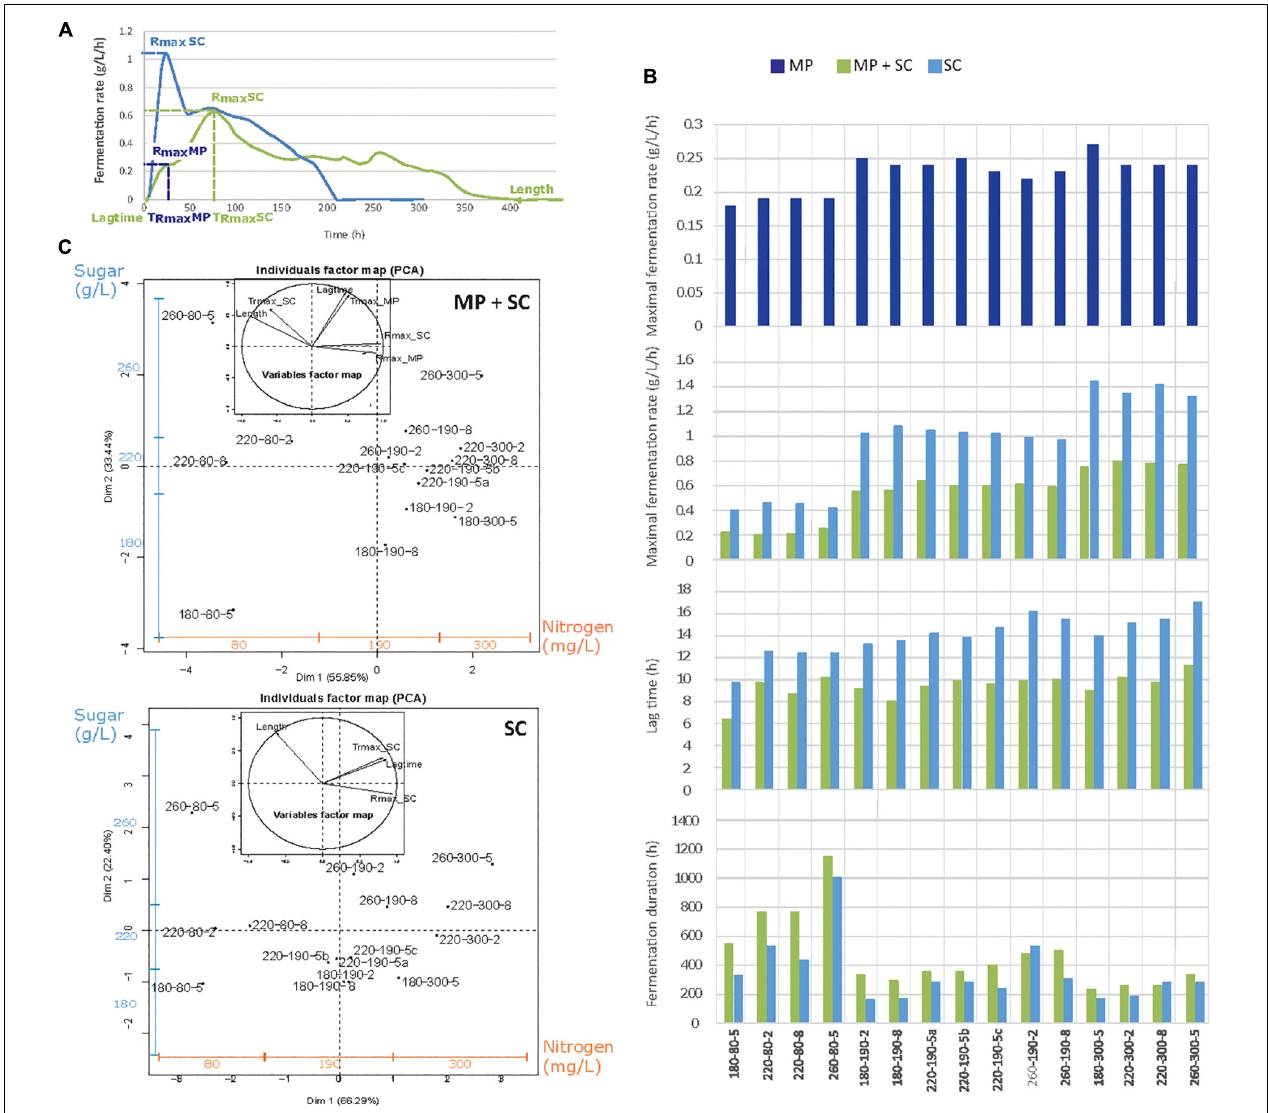
FIGURE 1 | (A) Example of the fermentation kinetics of M. pulcherrima and S. cerevisiae under sequential inoculation (MP + SC, green line) and S. cerevisiae in pure culture (SC, blue line). (B) Parameters describing the fermentation kinetics depending on the medium composition and inoculation strategy: Rmax_MP, maximal fermentation rate for M. pulcherrima reached before the inoculation of S. cerevisiae ; Rmax_SC, maximal fermentation rate for S. cerevisiae ; lag phase duration and fermentation duration. MP, dark blue bars: pure culture of M. pulcherrima . MP + SC, green bars: sequential fermentation. SC, blue bars: pure culture of S. cerevisiae . Conditions are labeled as sugar-nitrogen-lipids. (C) Principal component analysis (PCA) of fermentative parameters under the sequential inoculation of M. pulcherrima and S. cerevisiae and in pure cultures of S. cerevisiae . Individuals are identified as S-N-L, where S, sugar concentration; N, nitrogen concentration; and L, lipid concentration. The blue and orange additional axes indicate the repartition of individuals according to the concentrations of sugar (180–220–260 g/L) and nitrogen (80–190–300 mg/L). The inserts correspond to the correlation circles representing the explanatory variables. Trmax_MP and Trmax_SC, time to reach Rmax before and after the inoculation of S. cerevisiae